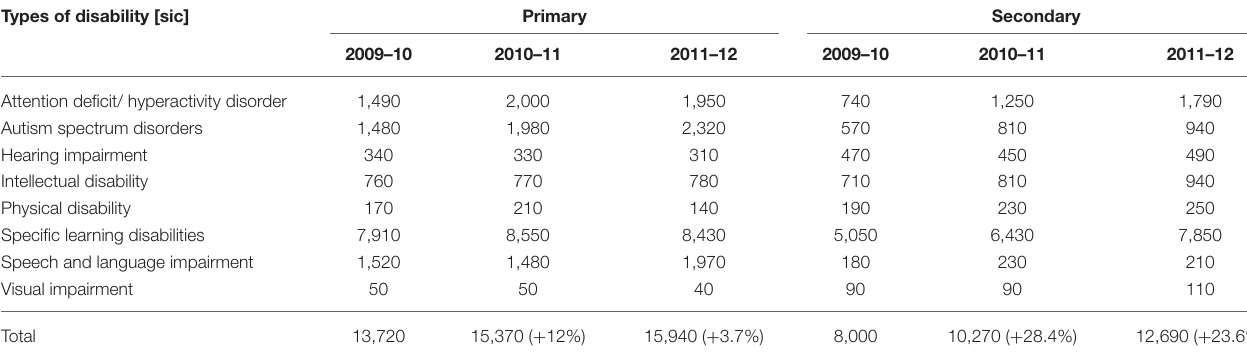
TABLE 2 | Students by major types of identified disability [sic] studying in mainstream primary and secondary schools (Legislative Council Secretariat, 2012). Types of disability